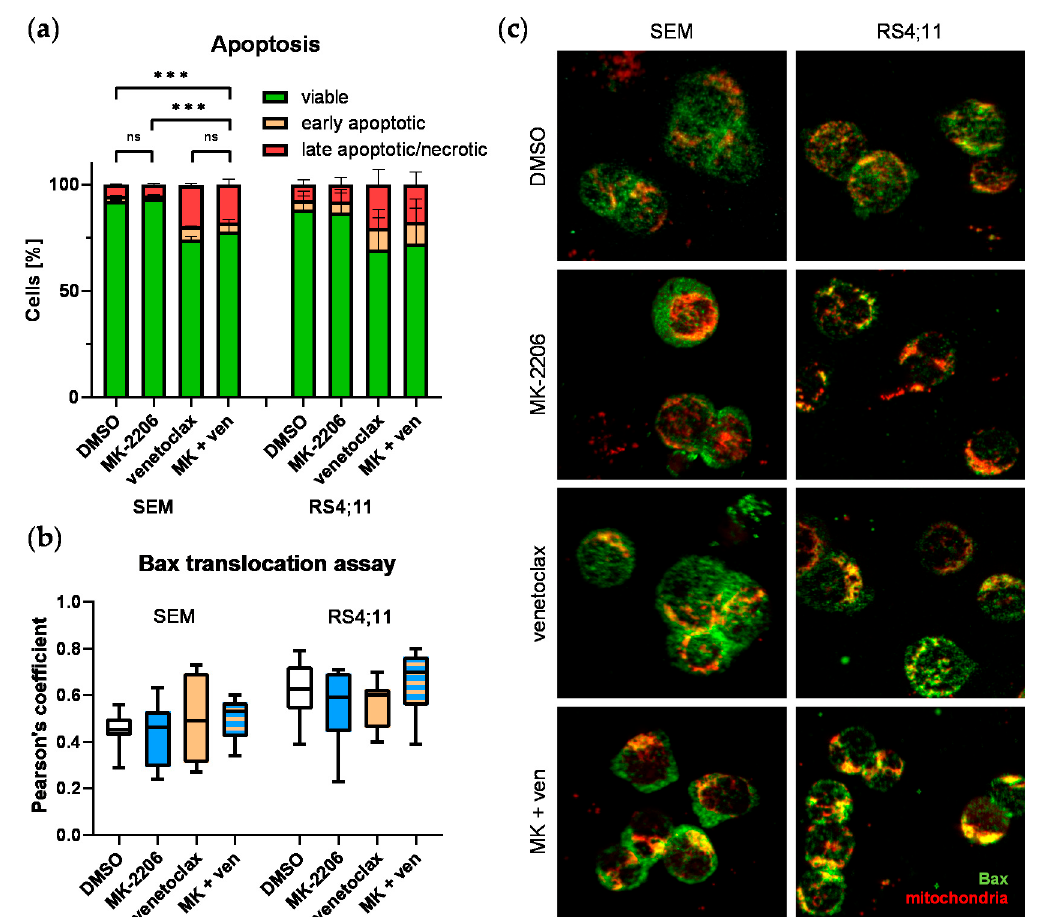
Figure 6. Analysis of apoptotic processes after single or combined MK-2206 (MK; 0.25 µM) and venetoclax (ven; 10 nM (SEM) or 2.5 nM (RS4;11)) incubation in SEM and RS4;11. ( a ) Cells were incubated for 72 h and stained with annexin V-FITC and PI. The amount of apoptotic cells was determined by flow cytometry with cells single positive for annexin V called early aposptotic and cells positive for both markers late apoptotic/necrotic. Mean ± standard deviation of at least three individual biological replicates. Significance was determined by one-way ANOVA. *** P < 0.001. ( b,c ) Downstream apoptotic signaling was investigated by Bax translocation assay. Cells were treated with one or both inhibitors for 48 h and spun onto microscopic slides. Mitochondria were stained using MitoSpy™ red and Bax protein was stained in green. Images were taken using the Eclipse TE200 microscope (Nikon) and at 40-fold magnification. Four biological replicates were performed for each treatment and two to four individual images per biological replicate were considered for colocalization analysis. ( b ) Color-merged images were split into separate images for both channels and regions of interest were marked using Fiji program. Colocalization analysis of Bax and mitochondria was performed using the Coloc2 plugin in Fiji and Pearson’s coefficient were used to quantify the amount of Bax/mitochondria overlap. ( c ) Representative images of SEM and RS4;11 cells treated with DMSO (control), MK-2206, venetoclax or both. Mitochondria are stained in red and Bax in green. Yellow signals are a product of red and green signal overlay and indicate colocalization of both structures.